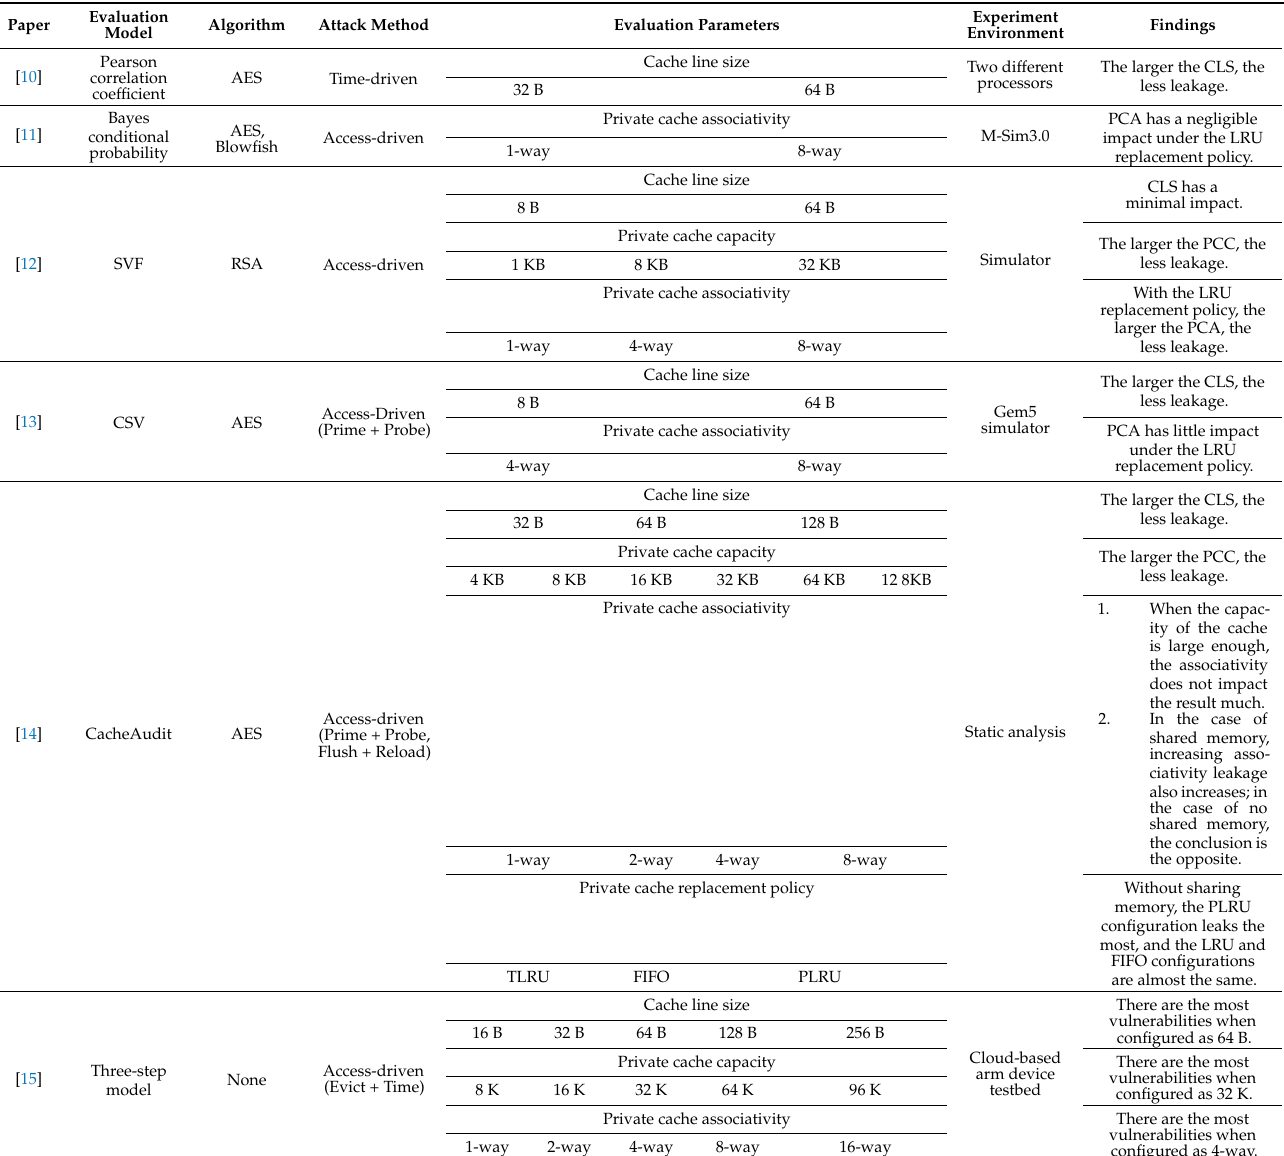
Table 2. Summary table of new therapeutic agents proposed to treat sarcopenia and muscle